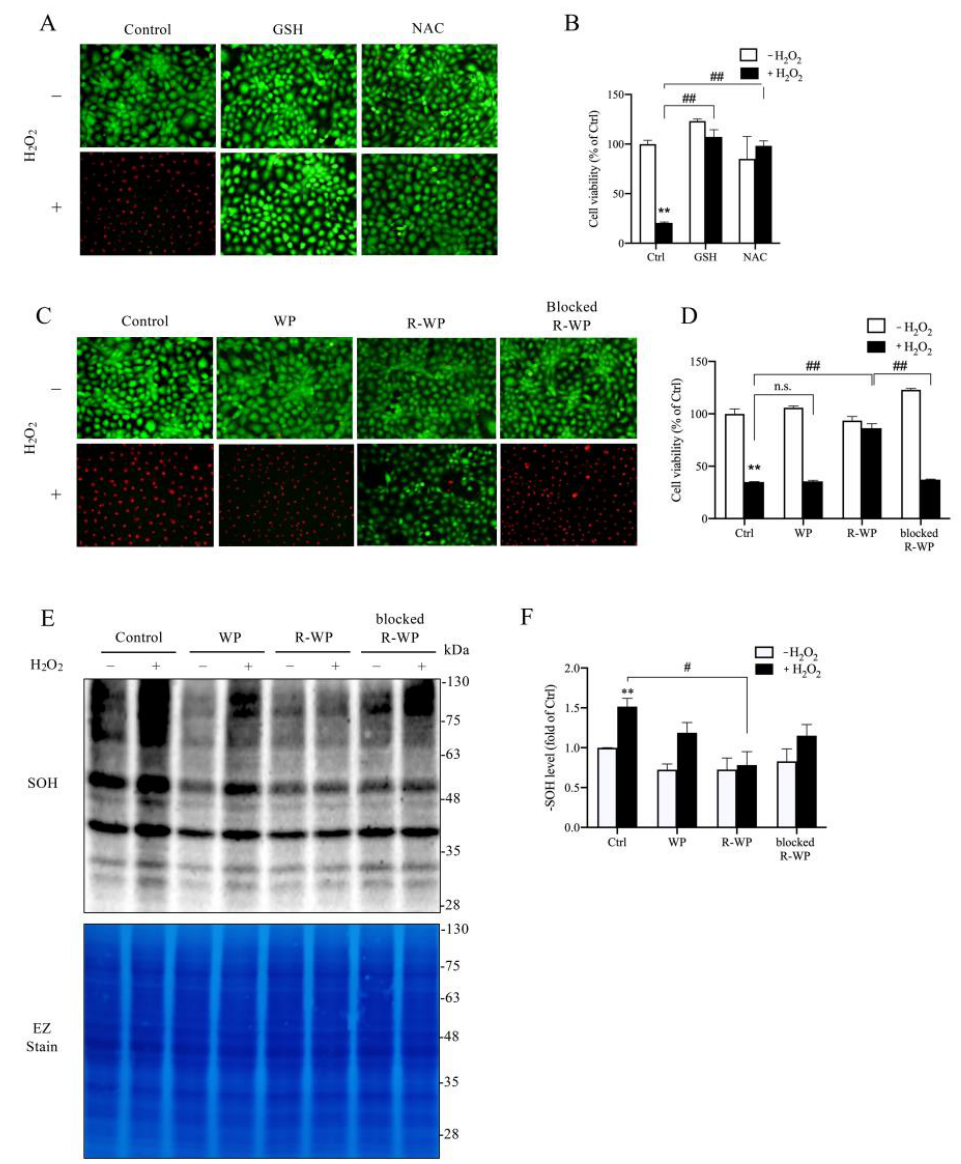
Figure 3. R-WP prevents H 2 O 2 -induced oxidative cell injury in cultured renal tubular epithelial